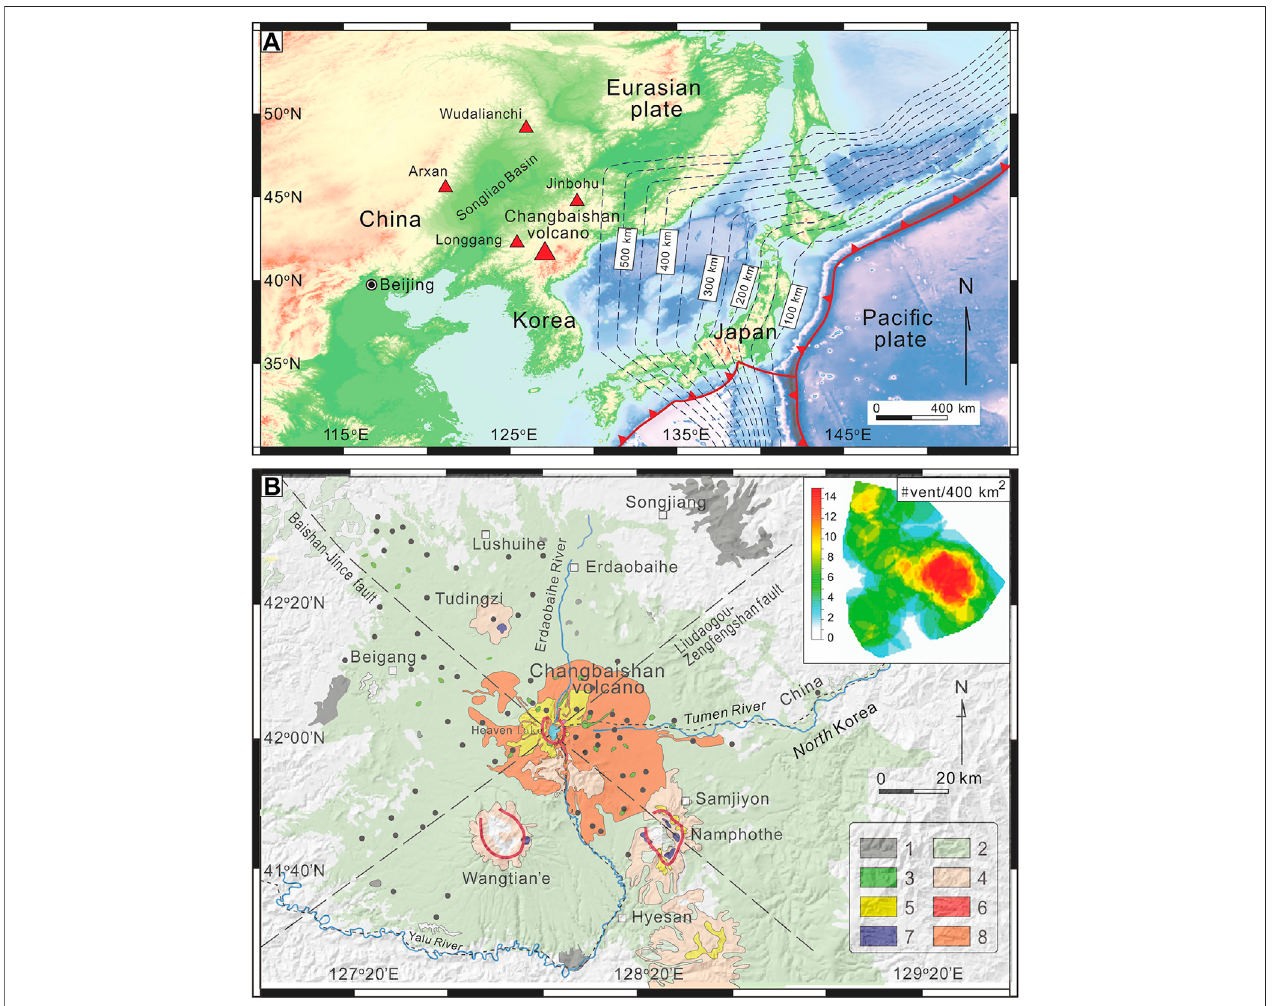
FIGURE 1 | (A) Schematic map showing location of the Changbaishan and other major volcanoes in NE China. The Japan trench is reported as red solid line with triangles and the depth of the Paci fi c slab is reported as dashed lines; the number indicates the depth in km (modi fi ed from Zhang et al., 2018; Chen et al., 2021; Fan etal.,2021;Sunetal.,2021). (B) GeologicalmapoftheChangbaiMountainsvolcanic fi eldshowingdistribution ofpolygenetic (Changbaishan(Tianchi),Wangtian ’ e,and Namphotheandmonogenetic(graydots)volcanoes.Geologicalmaplegend:1,pre-shieldbasalts;2,shield-formingbasalts;3,post-shieldbasalts;4,intermediate tosilicicvolcanicrocks (mainlytrachytewithminortrachyandesite);5,intermediate tosilicic volcanicrocks(mainly trachytewithminortrachyandesite);6,earlyrhyolite;7, rhyolite; 8, pyroclastic deposits (primarily trachytic and rhyolitic in composition) erupted by caldera-forming eruptions of Tianchi. The inset on the top right reports the spatial density of monogenetic